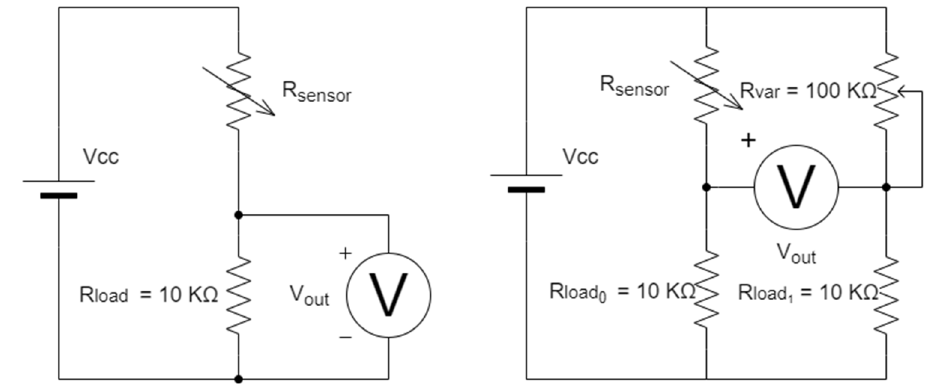
Figure 2. Voltage divider and Wheatstone bridge designs.